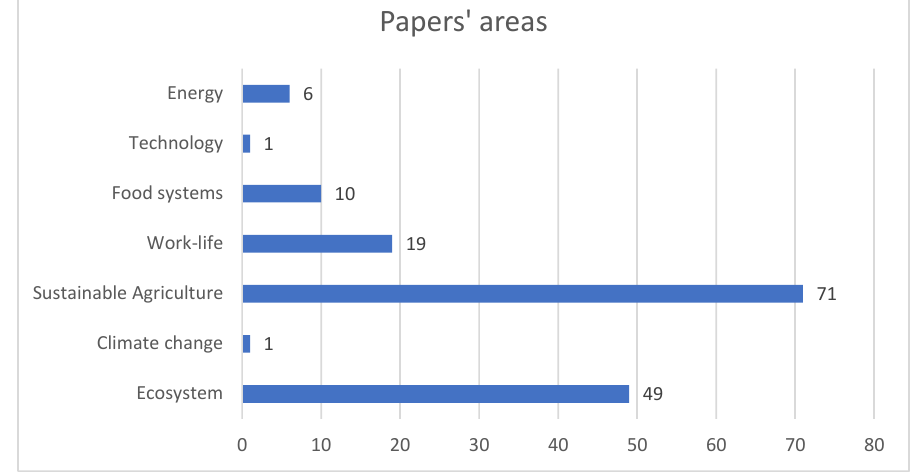
Figure 4. Papers’ topic area.